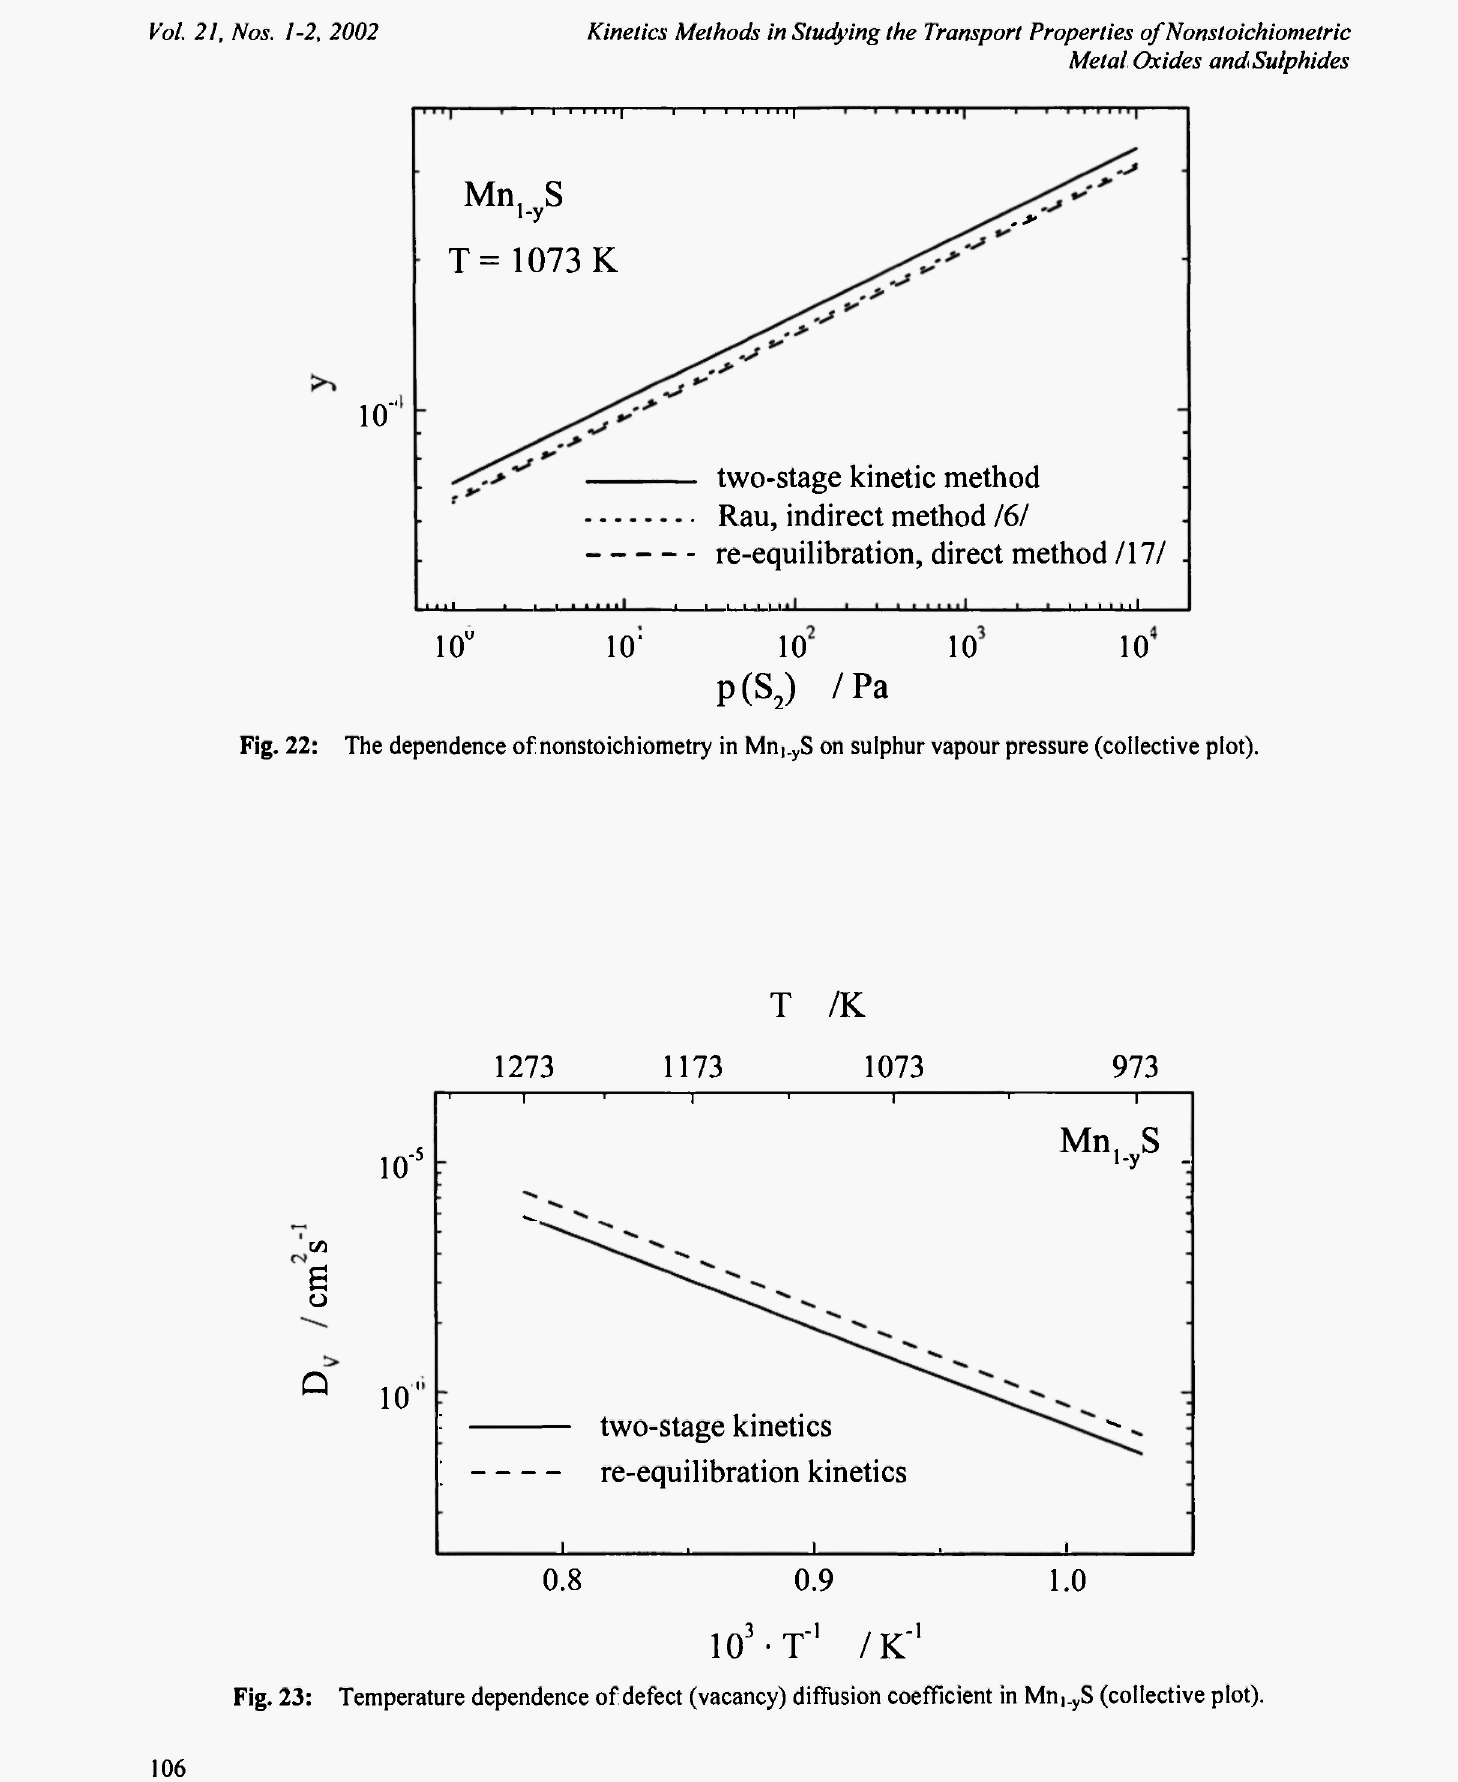
Fig. 23: Temperature dependence of defect (vacancy) diffusion coefficient in Mni_ y S (collective plot).